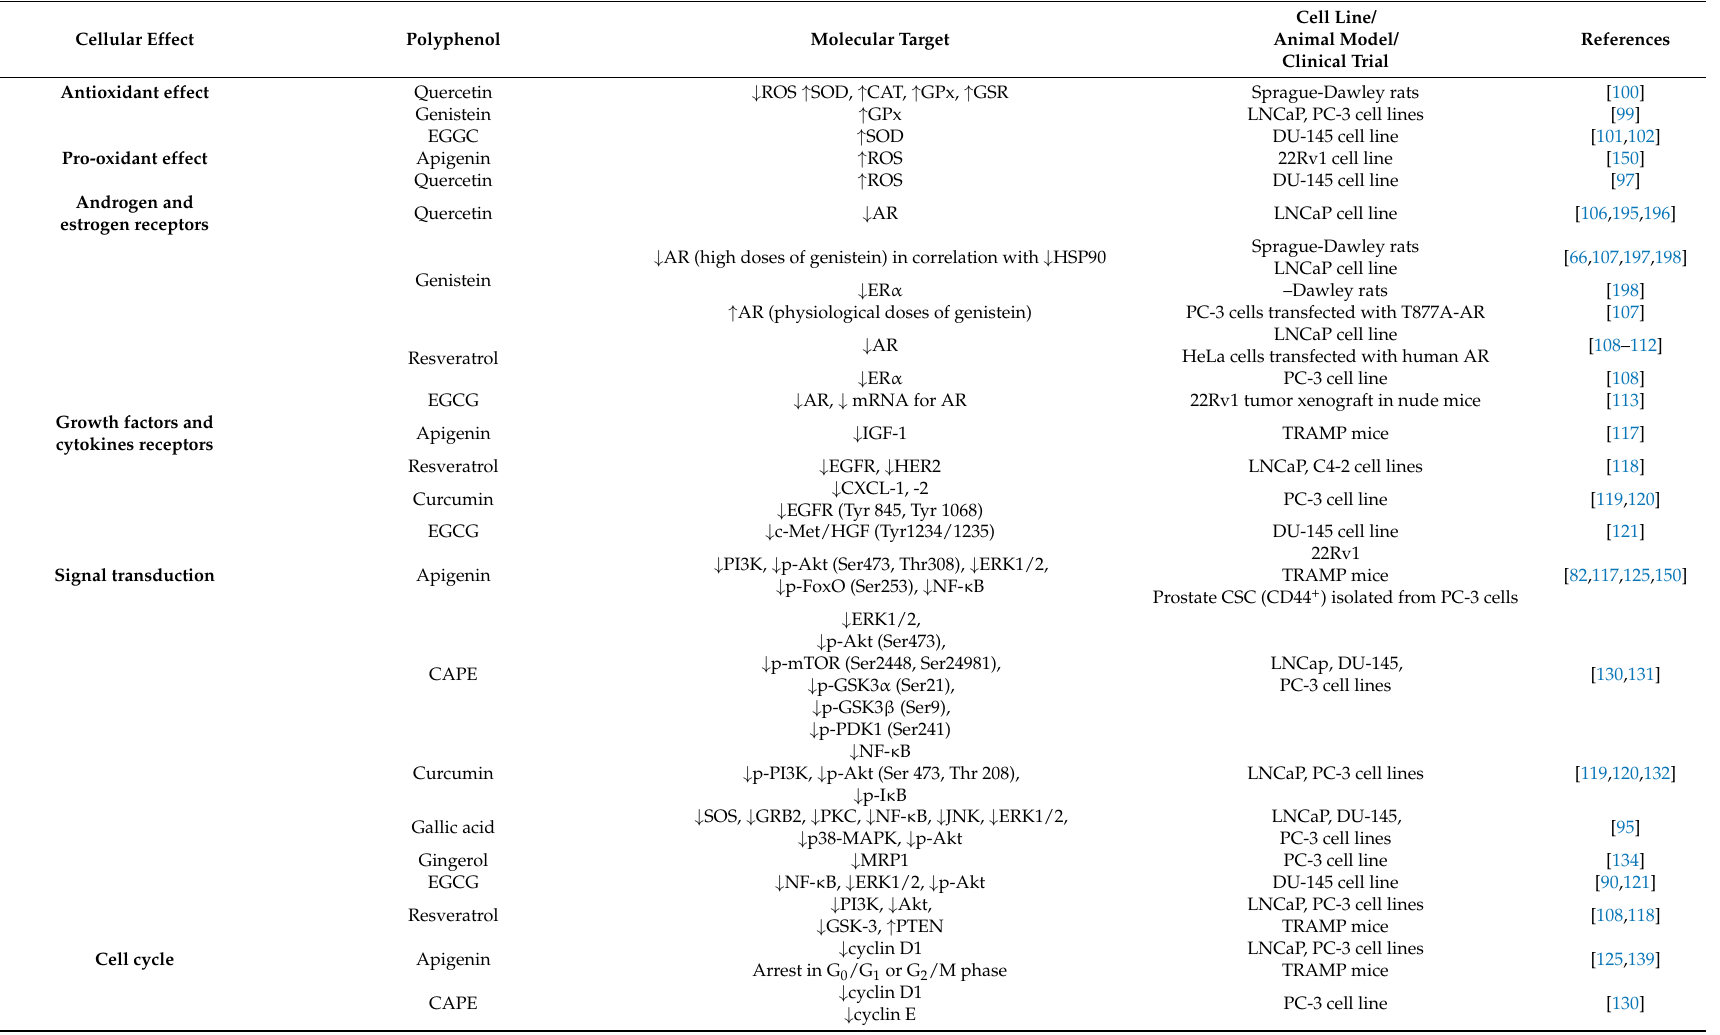
Table 3. Molecular targets for the dietary polyphenols in prostate